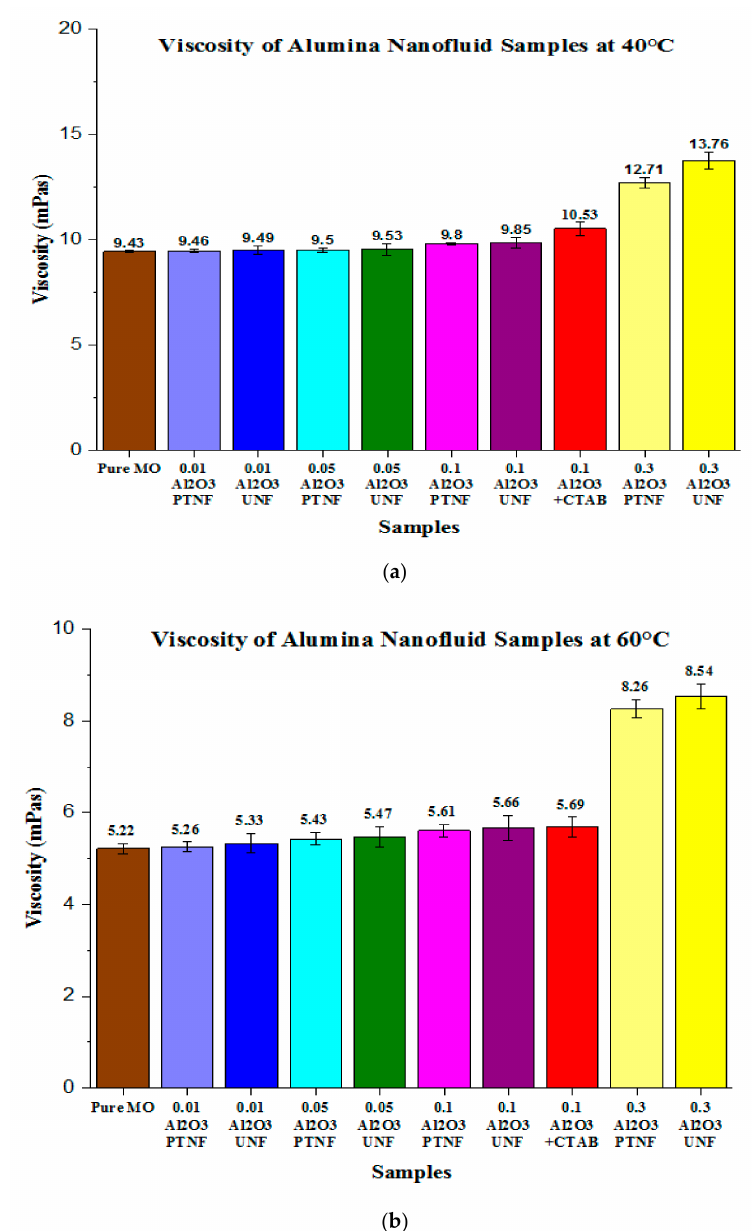
Figure 16. Average viscosity of pure MO and Al 2 O 3 nanofluid samples at ( a ) 40 ◦ C and ( b ) 60 ◦